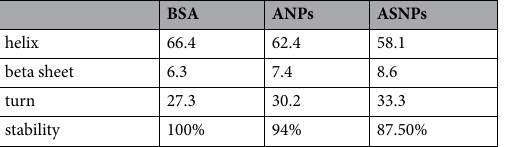
Table 1. Comparison between the stability percent and secondary structural changes in BSA, ANPs and ASNPs.